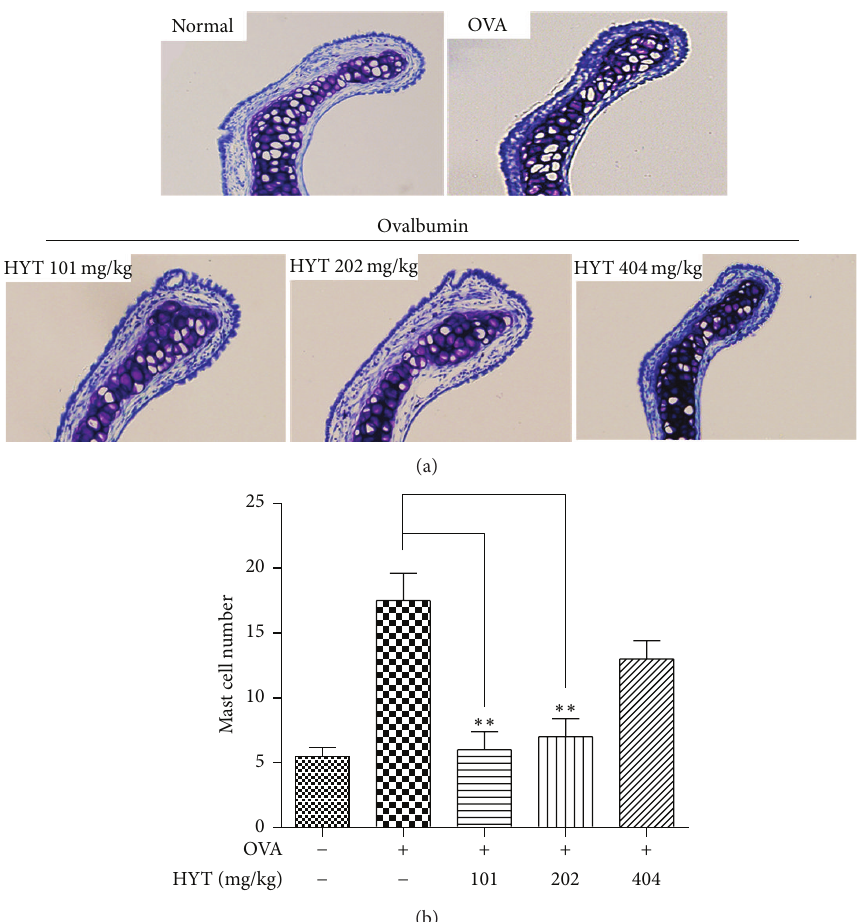
Figure 4: HYT reduced infiltration of mast cells into nasal mucosa. The nasal mucosa sections were stained with toluidine blue. Sections were evaluated using microscope at an original magnification of 200x. Data are presented as mean ± SEM. ∗ 𝑃 < 0.05 , ∗∗ 𝑃 < 0.01 , and ∗∗∗ 𝑃 < 0.001 .